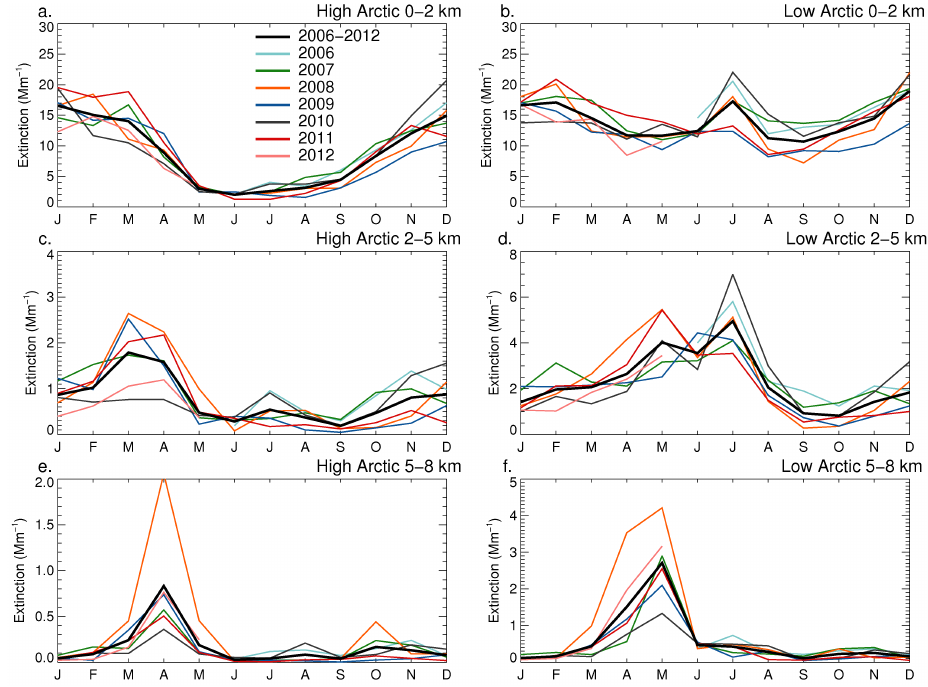
Fig. 13. Same as Fig. 9, but colored lines are for CALIOP nighttime-equivalent extinction for individual years between 2006 and 2012. The black lines correspond to the 6-year average (2006–2012) seasonal cycle of